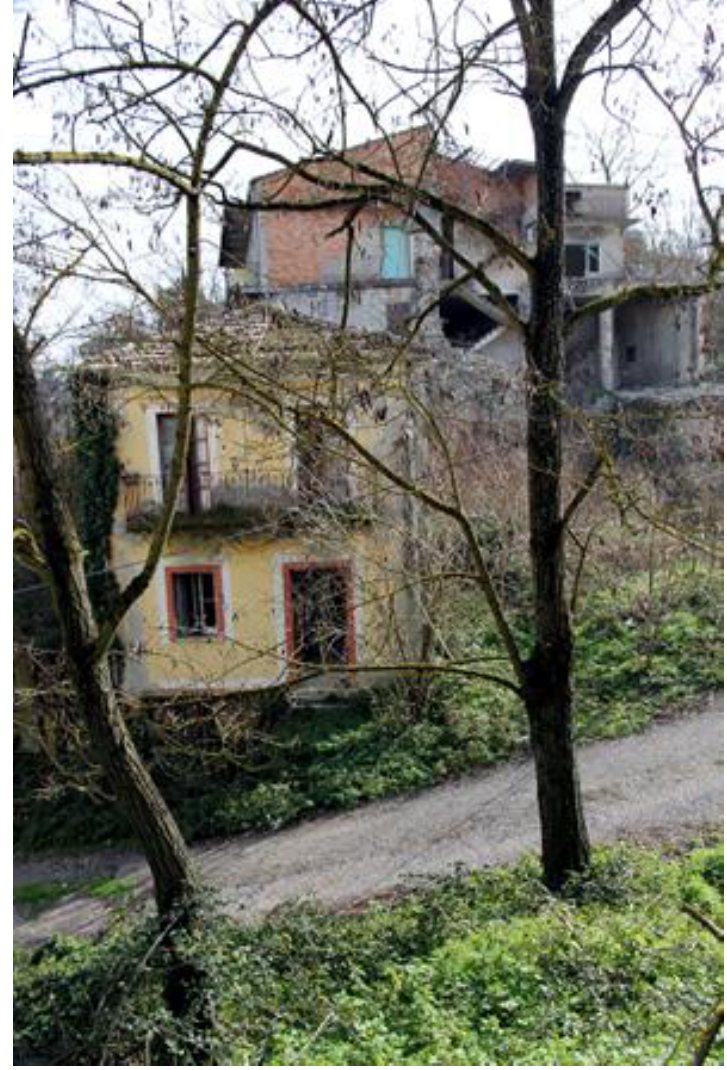
Figure 13. Conza della Campania: old village with houses rebuilt after the 1980 earthquake (photos by [35,36]).